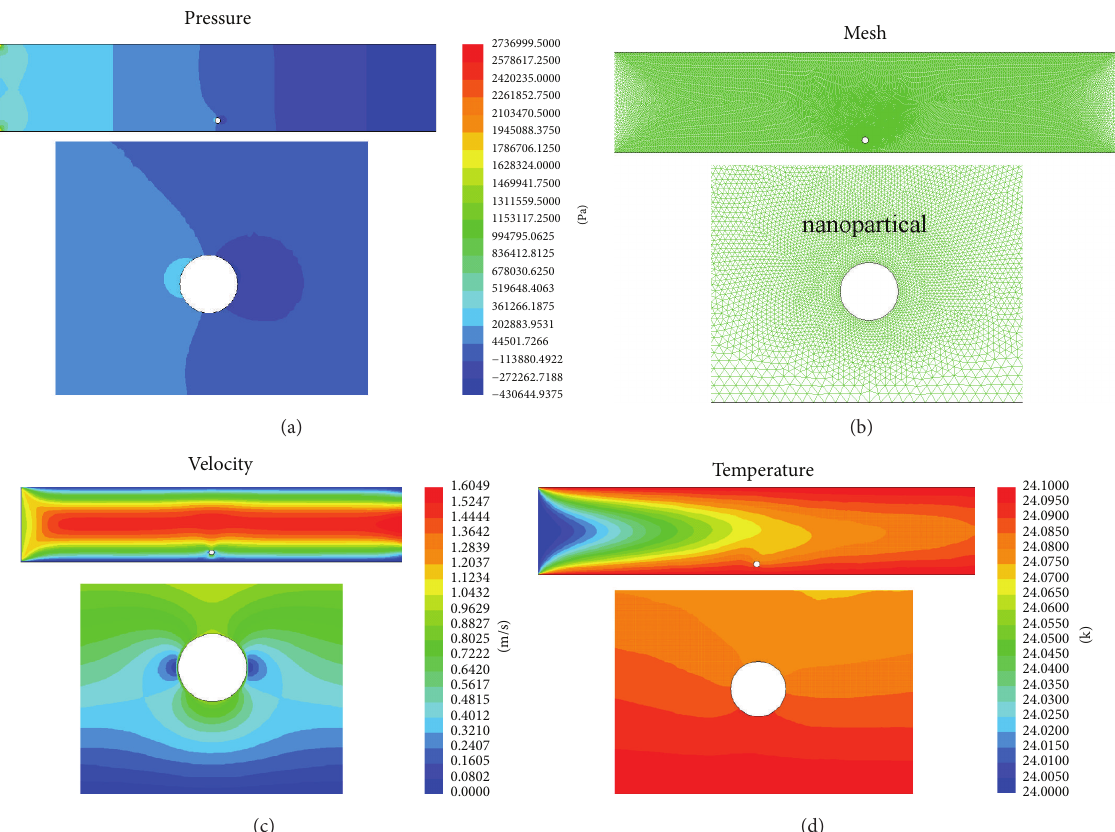
Figure 5: Case 2, velocity, temperature and pressure gradient, and mesh model (time = 0.001S).